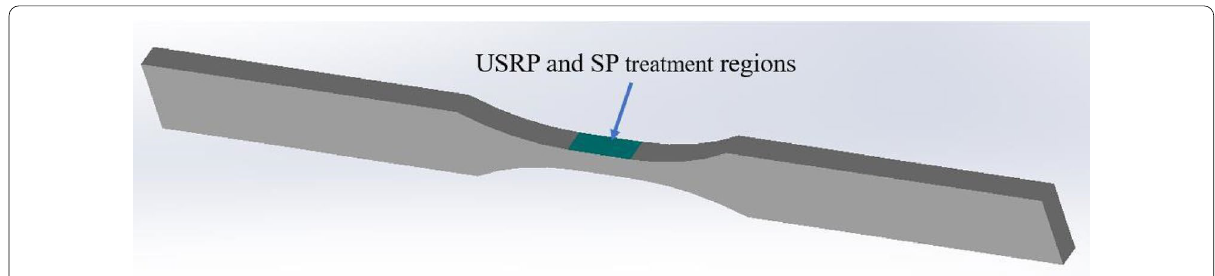
Figure 6 Schematics of USRP and SP treatment regions